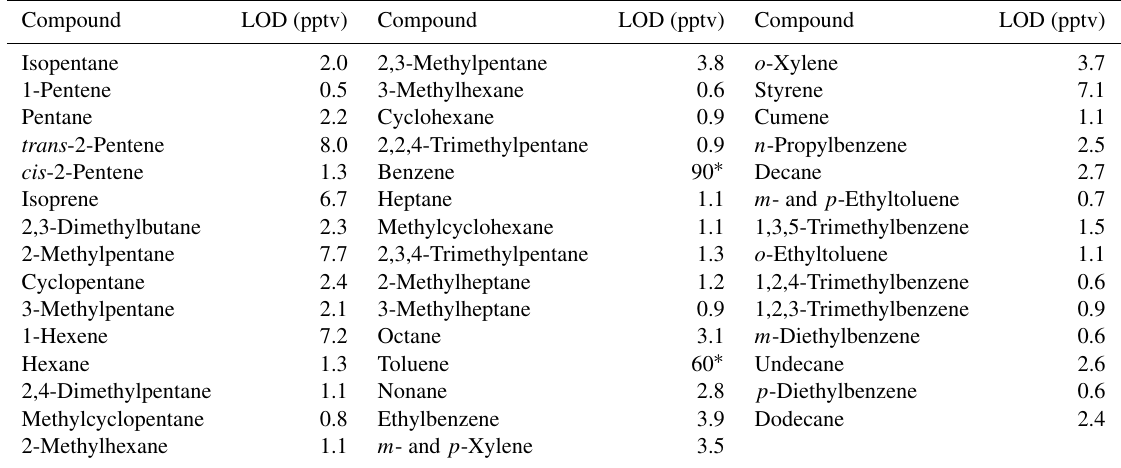
Table 2. Limits of detection (LODs) for a selection of linear, branched and aromatic hydrocarbons on the I/VOC channel of cTAG. Com- pounds are presented in order of volatility from isopentane (5 carbon atoms) to dodecane (12 carbon atoms). Compound LOD (pptv) Compound LOD (pptv) Compound